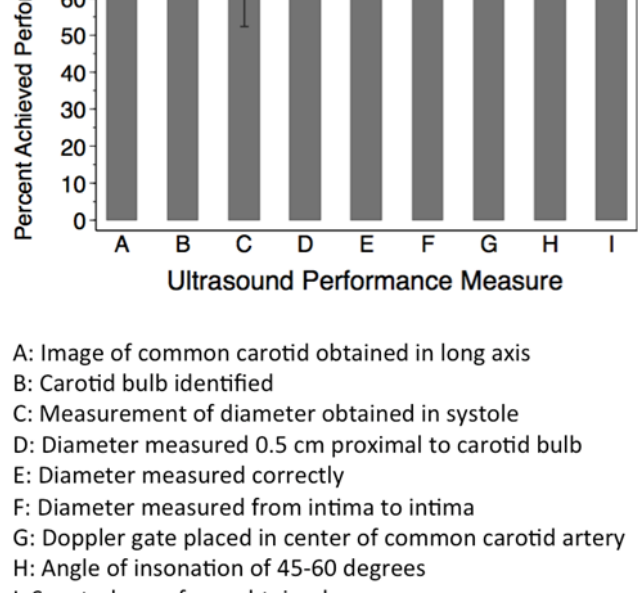
Figure 3. Percent successful completion of ultrasound performance measures. I-bars represent 95% confidence intervals. N = 30